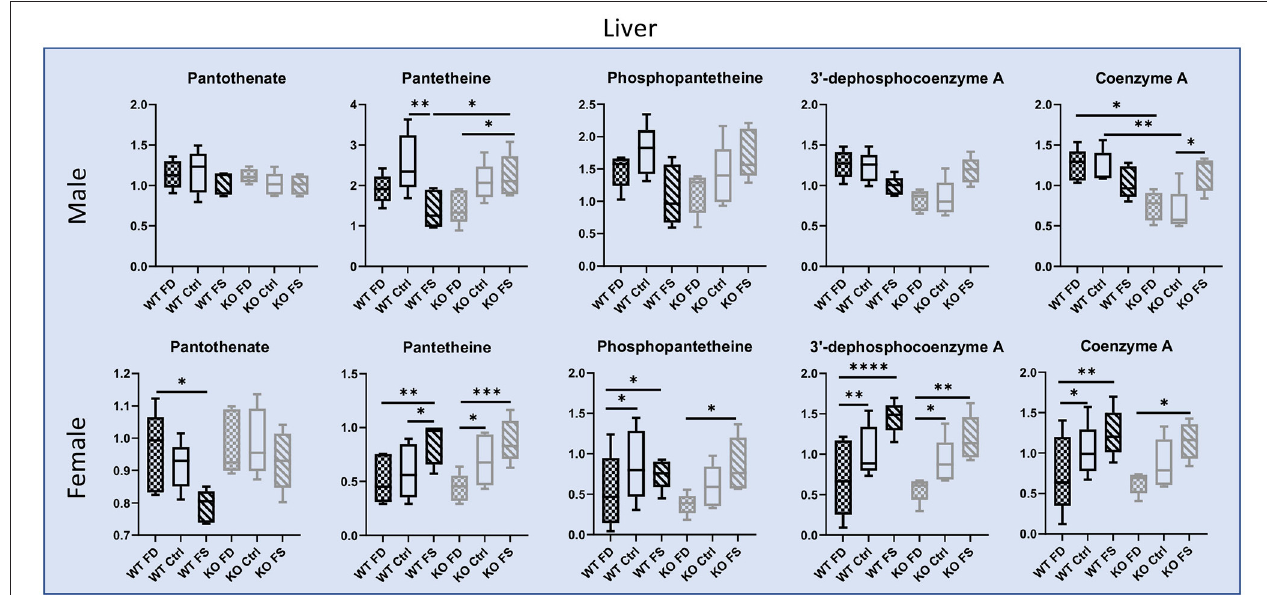
FIGURE 5 | Vitamin B 5 liver concentrations in males show no difference between genotypes or FA supplementation, while B 5 metabolites responded to dietary FA differently in WT and CerS6 KO male mice. Most pantothenate metabolites showed a dose response relationship with dietary FA in female mice except pantothenate. Data are shown with minimum and maximum, with bar at median value, n = 5. Checked bars, FD diet; solid bars, Ctrl diet; striped bars, FS diet. WT is shown in black, and KO is shown in gray. * p < 0.05; ** p < 0.01; *** p < 0.001; **** p < 0.0001; determined by ANOVA